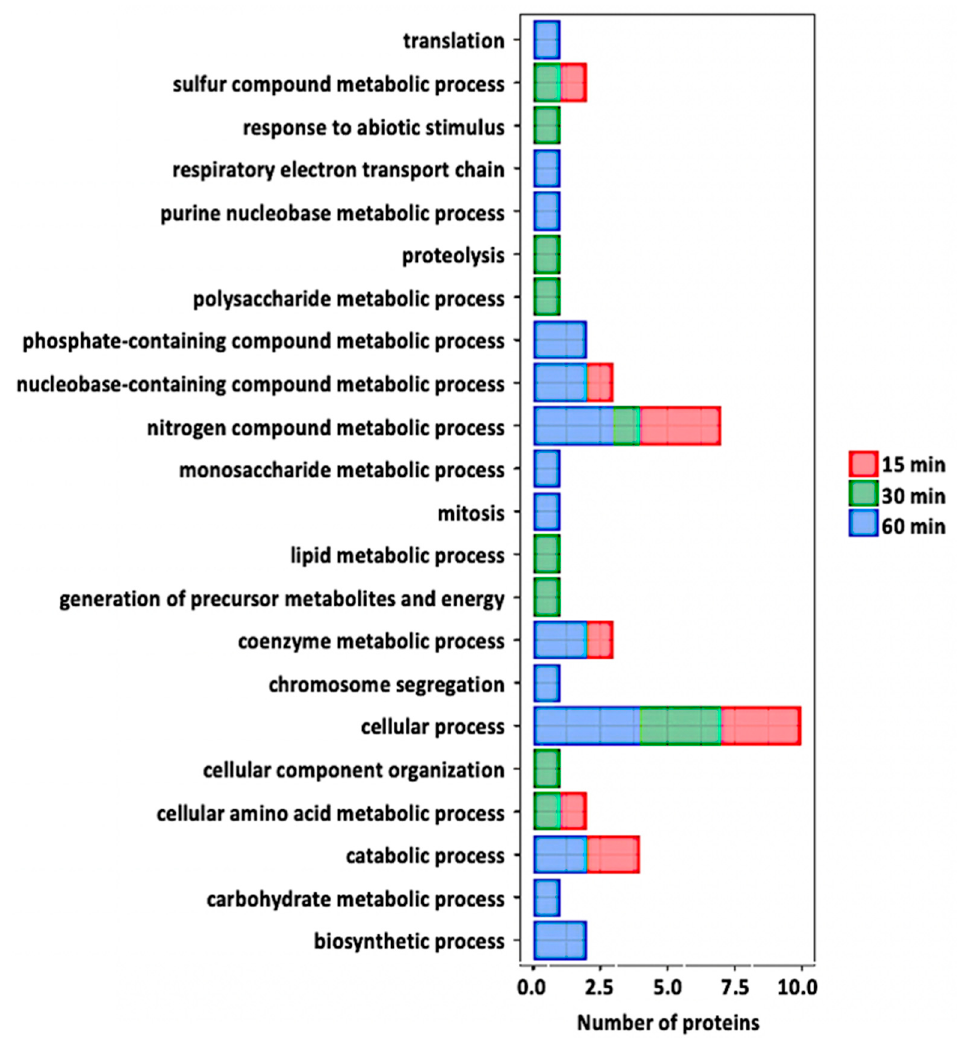
Figure 5. Gene ontology analysis of the redox proteins after flg22 treatment. Relevant biological processes are shown on the y -axis. Number of proteins significantly redox-regulated at each time point after treatment is shown on the x -axis.